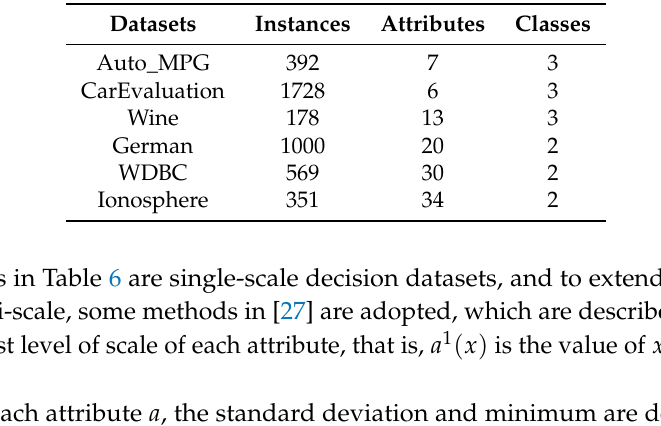
Table 6. The UCI dataset